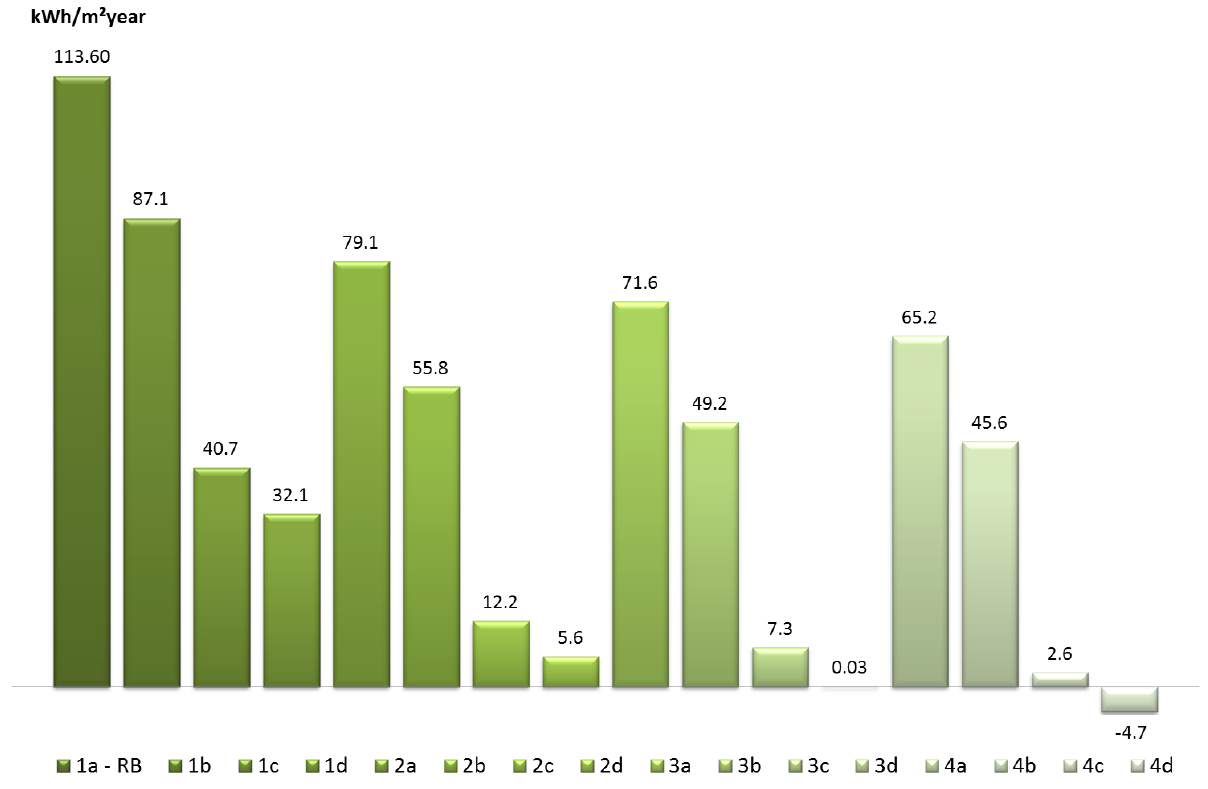
Figure 8. Primary energy consumption for every energy design